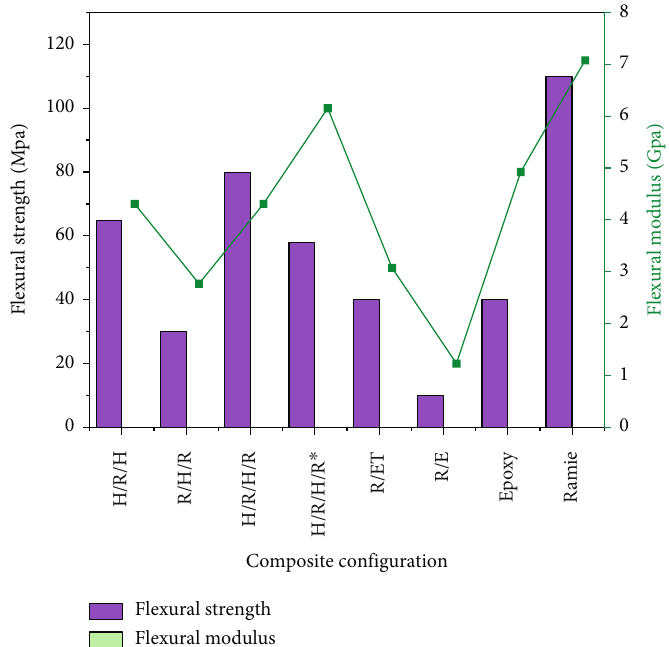
Figure 6: Flexural strength and fl exural modulus of R/H hybrid composites, R/E, pure epoxy, and H/E.